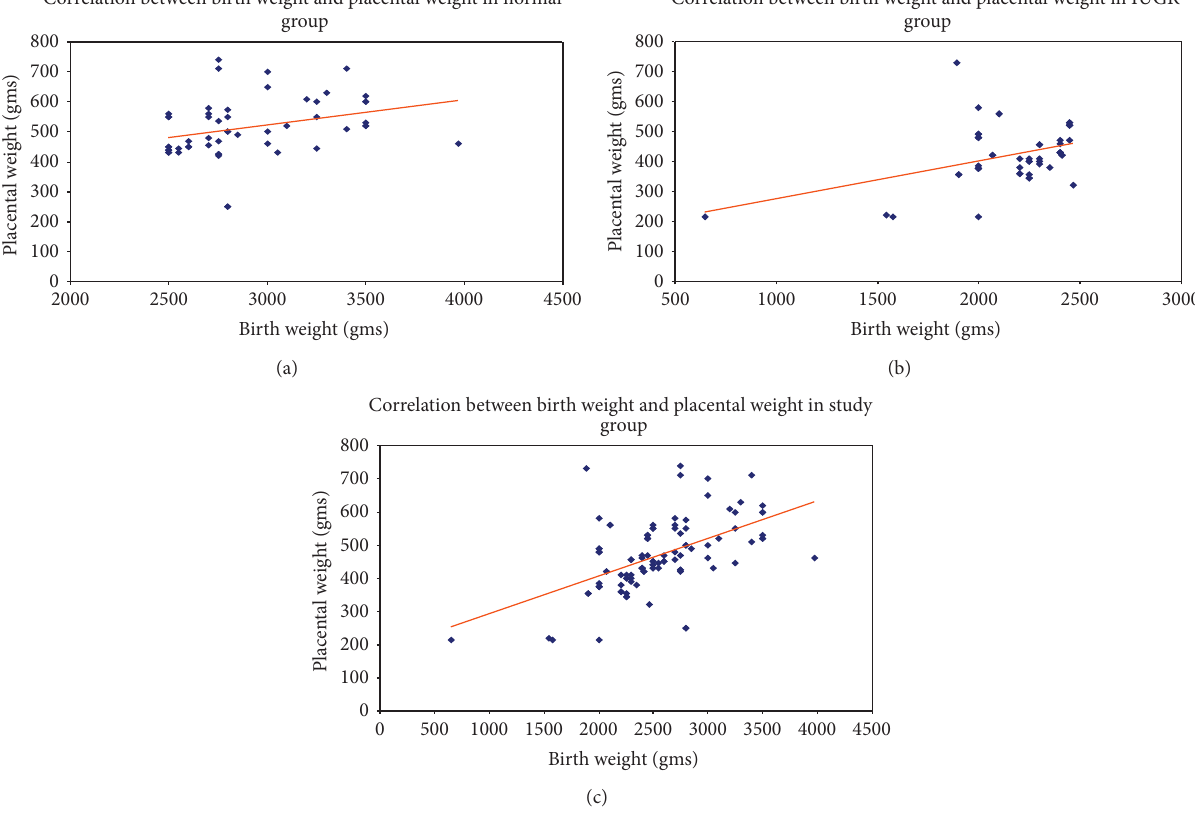
Figure 1: (a) The scatter diagram showing the correlation between birth weight and placental weight in the normal group. (b) The scatter diagram showing the correlation between birth weight and placental weight in the group with fetal growth restriction/intrauterine growth restriction (IUGR). (c) The scatter diagram showing the correlation between birth weight and placental weight in the entire study group combining normal fetuses and group with fetal growth restriction/IUGR. Table 8: The comparison of placental diameter in study